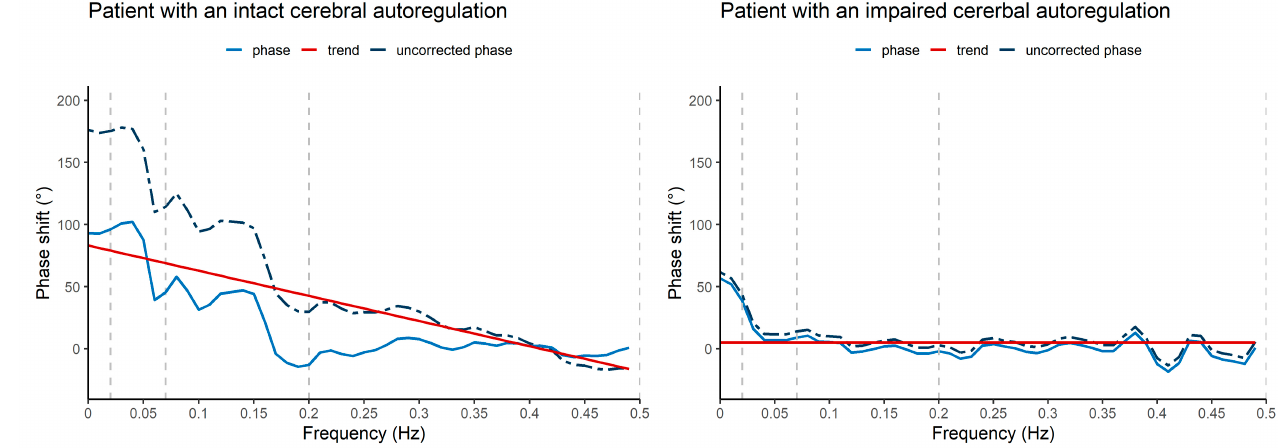
Figure 2. TFA-phase shift plot examples in two patients (ten-minute segment) of intact/impaired CA estimations. ( A ) shows a segment with a ‘high pass’ filter concept configuration and TFA VLF and LF numbers assuming working CA (mean LF-phase shift 19 ◦ ). ( B ) shows a segment with a ‘flat line’ with minimal HF correction. No ‘high-pass’ filter principle configuration is seen and VLF and LF-phase shift numbers are close to zero (mean LF-phase shift 2 ◦ ), assuming impaired CA. The dashed dark blue curve is the uncorrected phase shift computed for the frequency range 0.01–0.5 Hz. The lighter blue line is the phase shift computed after subtraction of the red linear HF trend line from the uncorrected phase shift. The dashed vertical grey lines delineate the frequency ranges for the VLF (0.02–0.07 Hz), LF (0.07–0.2 Hz) and HF (0.2–0.5 Hz) range. CA = cerebral autoregulation; deoxyHb = deoxyhemoglobin; HF = high frequency range; LF = low frequency range; oxyHb = oxyhemoglobin; TFA = transfer function analysis; VLF = very low frequency